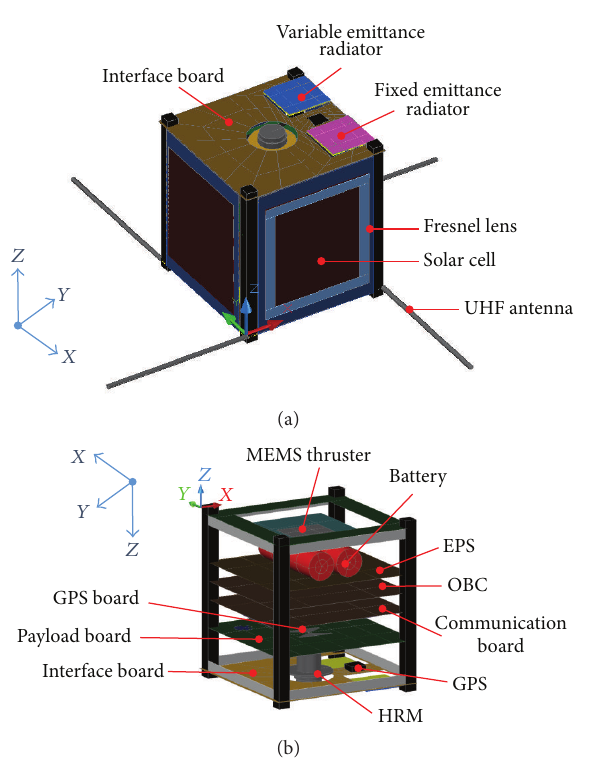
Figure 8: TMM of STEP Cube Lab ((a) external, (b) internal).